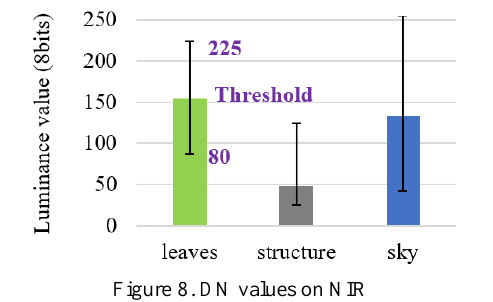
Figure 8. DN values on NIR